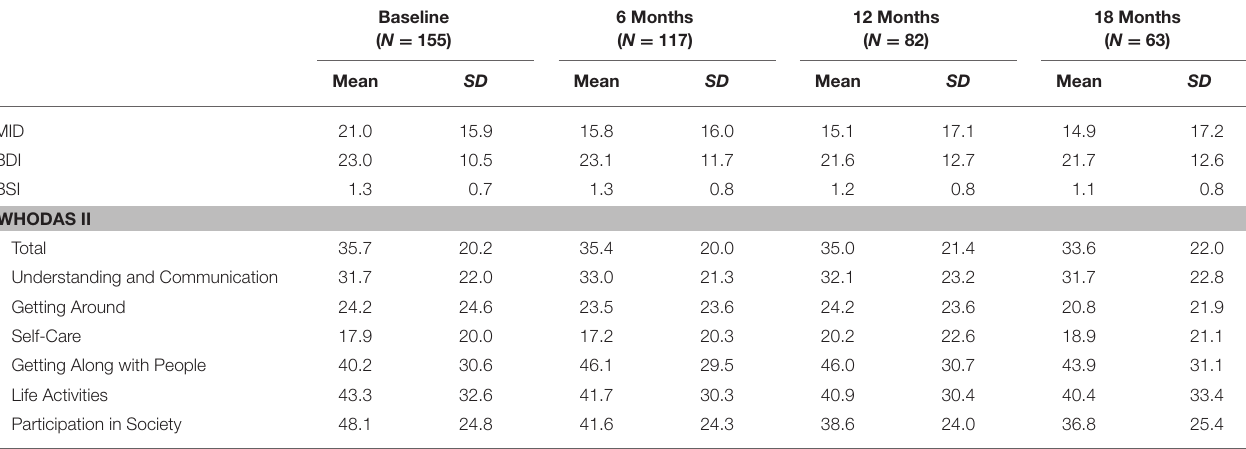
TABLE 2 | Symptom severity and functional impairment across 18 months of outpatient and daycare patients.